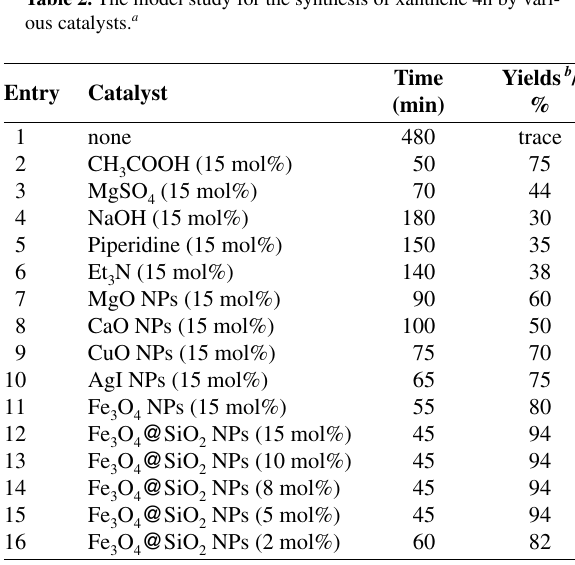
Table 1. The model study in different solvents using Fe NPs. a Entry Solvent T /°C Time/min Yields b /%